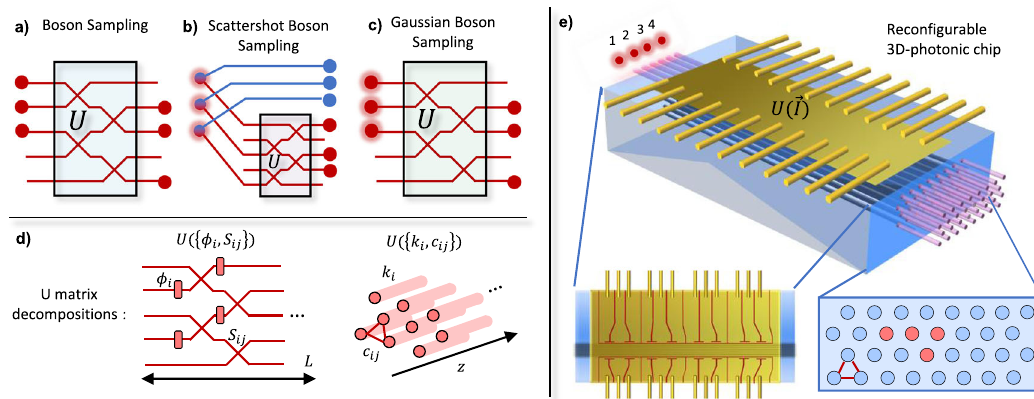
Fig. 1 Boson Sampling in a 3D continuous-coupling integrated device. a Boson Sampling (BS) and the most recent variants, ( b ) Scattershot Boson Sampling (SBS) and ( c ) Gaussian Boson Sampling GBS). The corresponding computational problems require sampling from the output distribution using different input quantum states of light, such as Fock states in BS, two-mode squeezed vacuum states in SBS and single- mode squeezed vacuum states in GBS. The common element among the schemes is the optical random circuit, described by the unitary evolution U . d The most widely adopted decomposition of the operator U is via a network of beamsplitters, with splitting ratios S ij , and phase- shifts ϕ i (left); an alternative implementation exploits continuous-coupling by evanescent waves among waveguides (right) depending on the coupling coef fi cients c ij and the propagation constants k i , where both may vary along the direction z . e Overview of the recon fi gurable 3D integrated photonic chip, realized through the femtosecond laser writing technique. The device is composed by 32 optical-modes arranged in a triangular lattice, as showed in the inset reporting the transverse section of the sample. In red we have highlighted the input modes employed in the 3- and 4-photon experiment. The transformation U is controlled by the 16 resistors fabricated on top of the glass sample. The second inset shows the top view of the electrical circuits that controls the currents I i applied to the